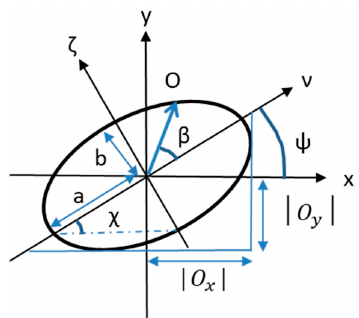
Figure 3. Polarization ellipse. The ellipticity is given by the ratio of the length of the semiminor axis to the length of the semimajor axis, b/a = tan( χ ). The ellipse is further described by its azimuth ψ , measured counterclockwise from the x axis [10].